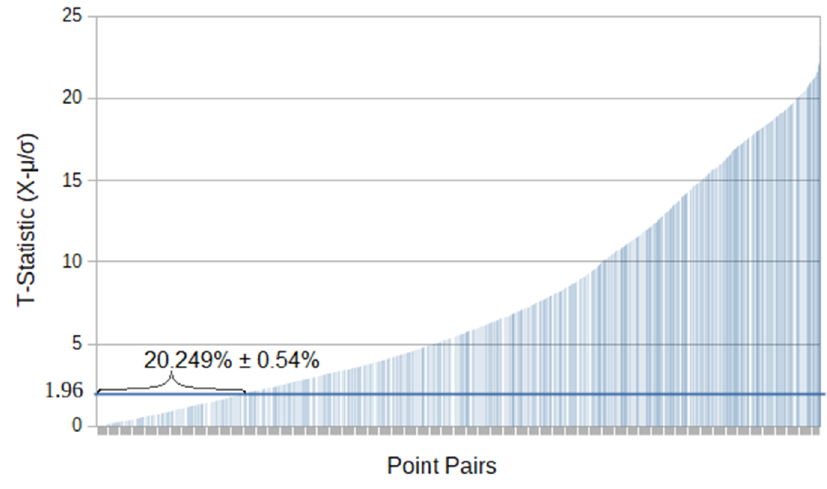
Figure 23. Sorted distribution of t-statistic values produced from point pair differences ( dh ij,DTM − dh ij,acoustic ) along with estimated standard deviations. The line indicates the critical t-value ( df → ∞ , a =